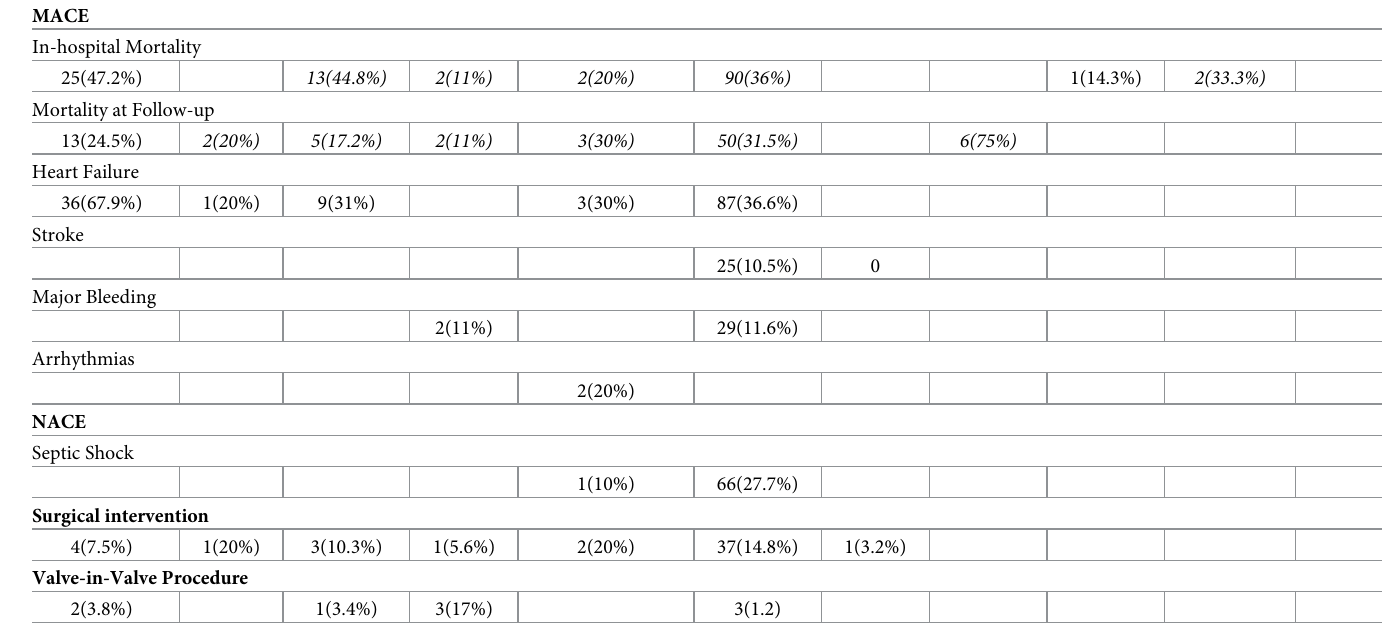
Table 5. Clinical outcomes of post-TAVI infective endocarditis. Amat-Santos Olsen Martinez-Selles Regueiro Seiffert Kosek Gallouche